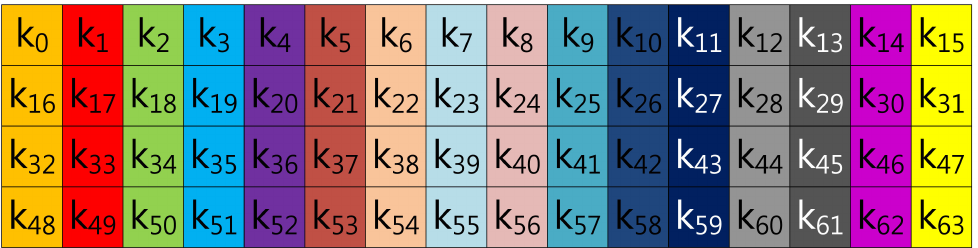
Figure 1. Look-up table structure of Lim and Lee’s method in a block